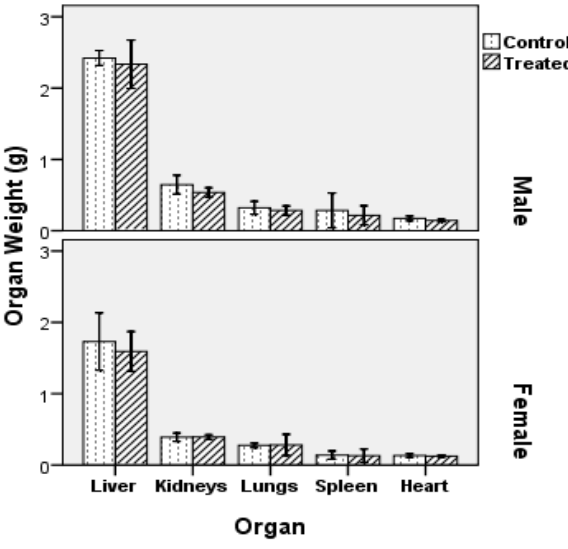
Figure 2. Internal organ mass of Swiss Albino mice after two weeks